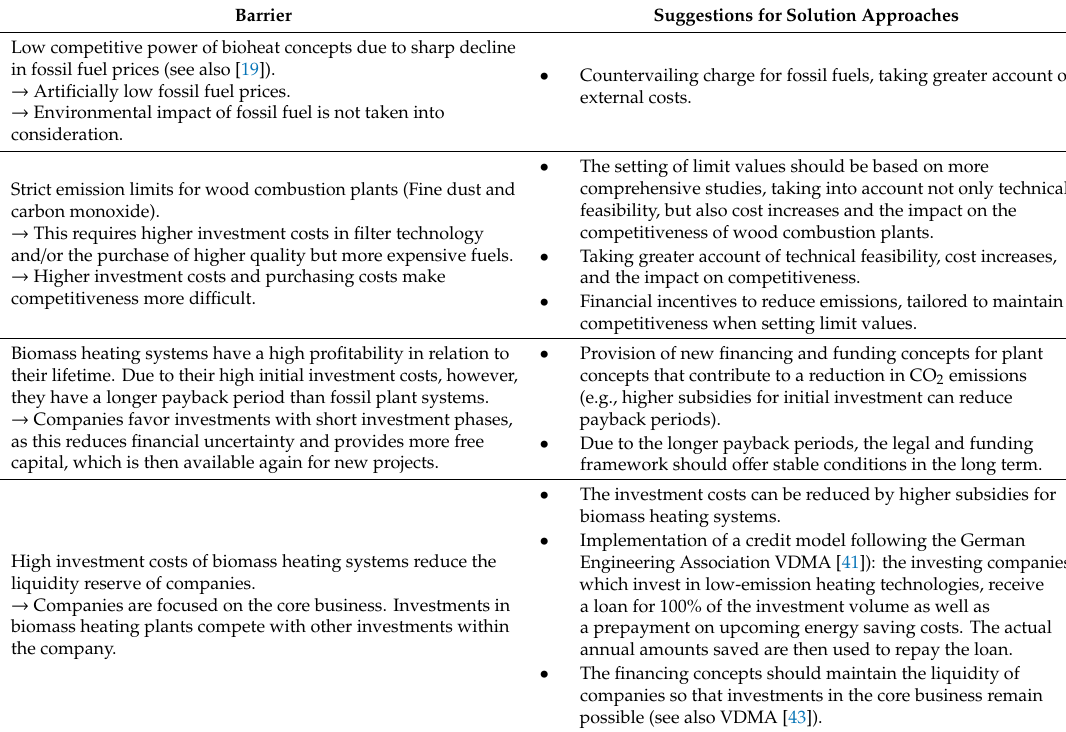
Table 2. Economic hurdles and approaches to further expand of bioheat concepts (partly cited and revised from [42]).